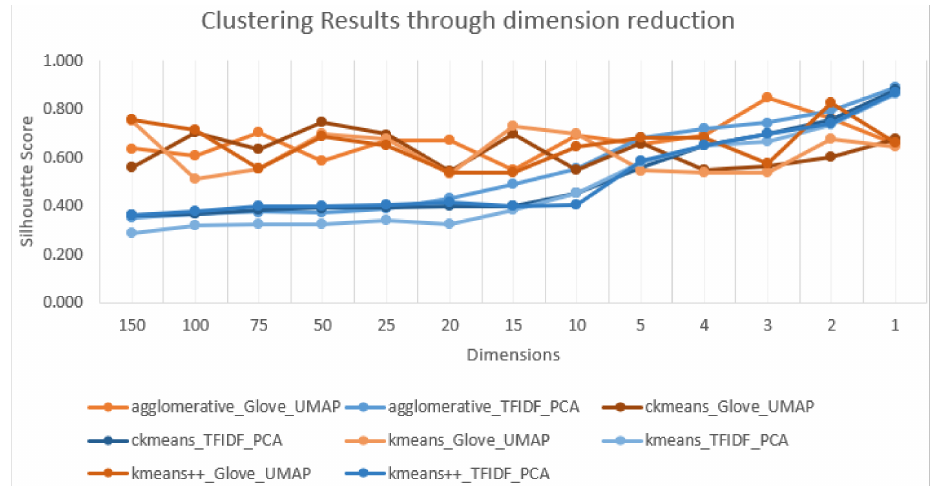
Figure 6. Clustering results through dimension reduction on the baseball dataset.